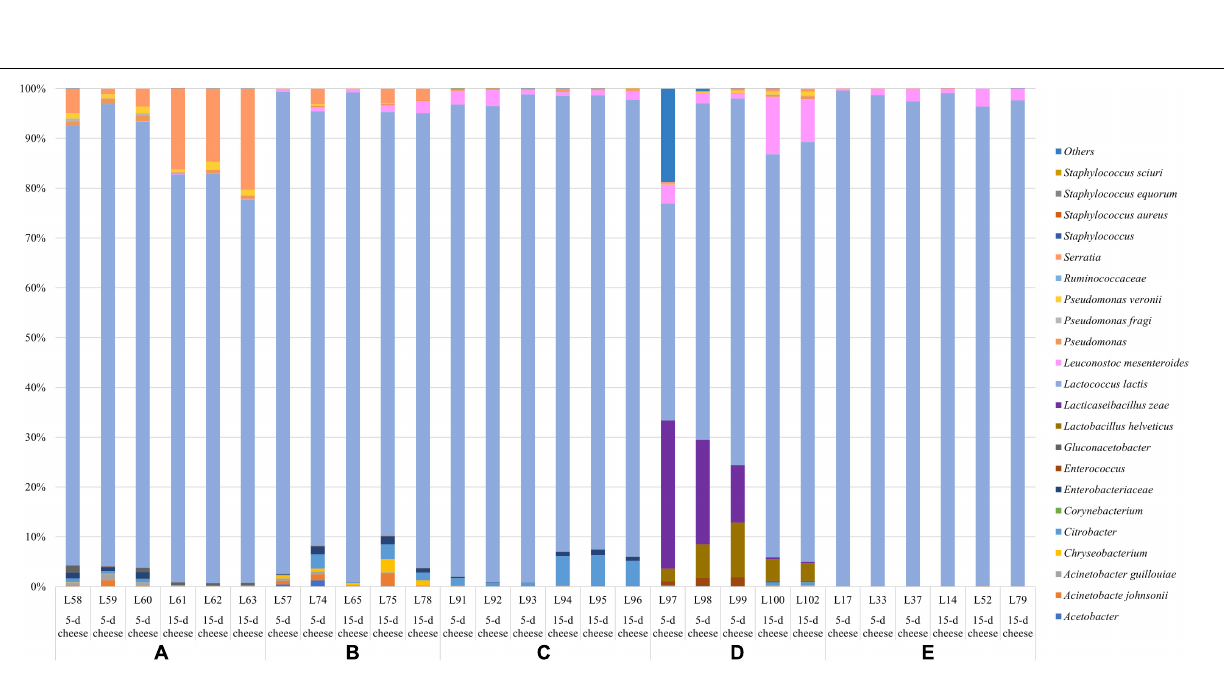
Frontiers in Microbiology |